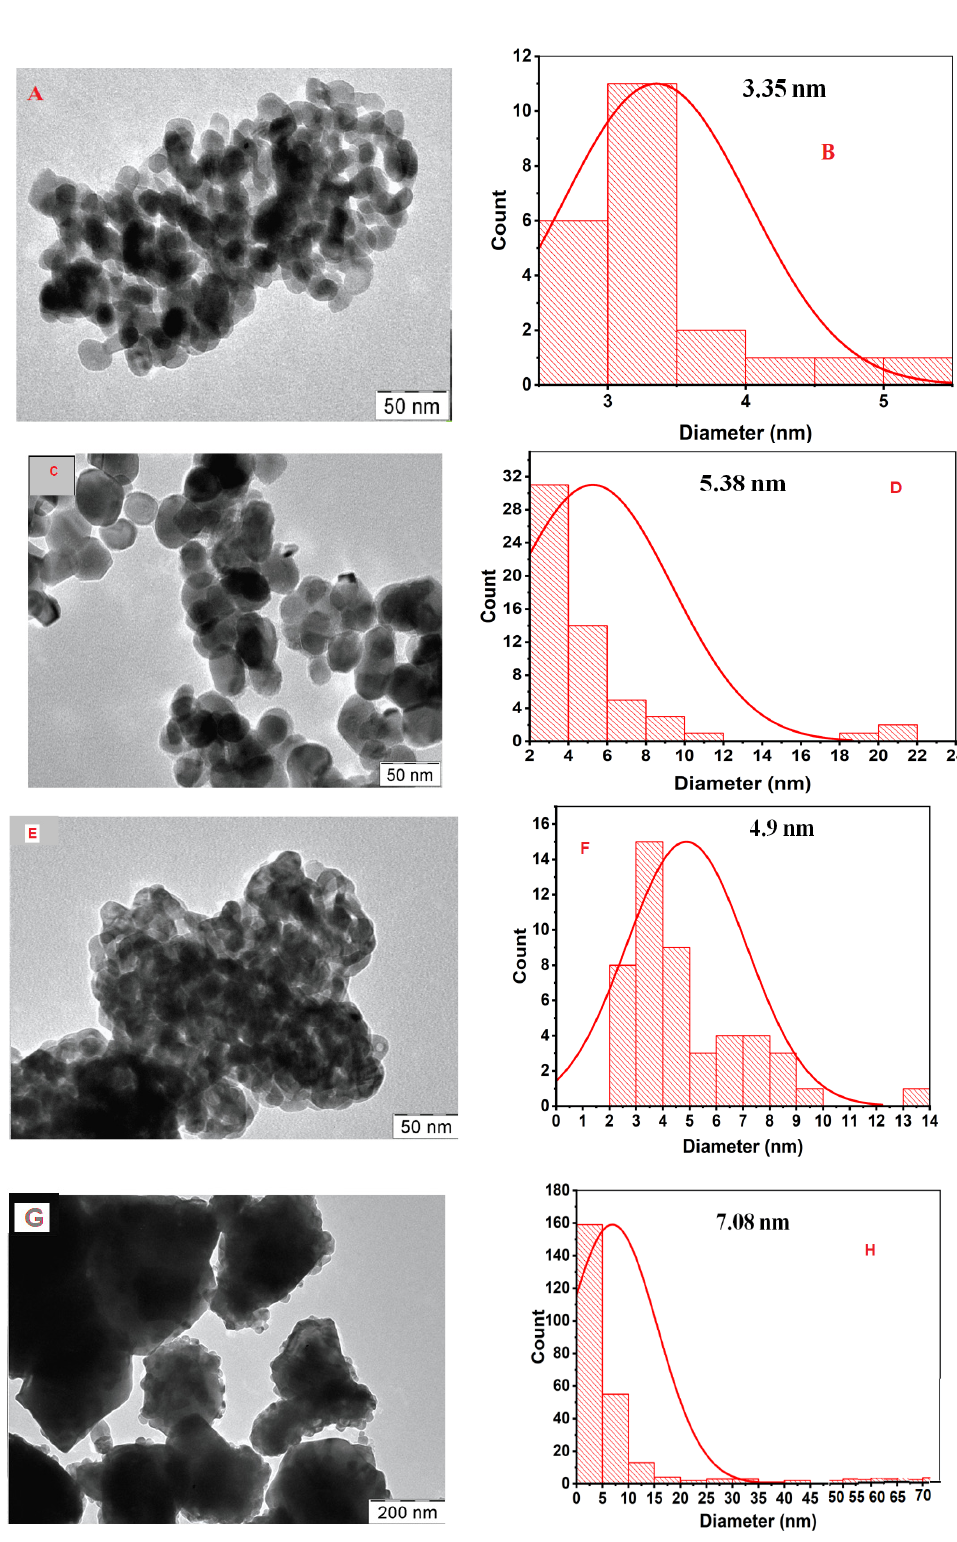
Figure 5. TEM images and matching particle size distribution for fresh: ( A , B ) 5Ni-RC100, ( C , D ) 5Ni-ELTN, ( E , F ) 5Ni-Z- 3215, and ( G , H ) 5Ni-MKnano catalysts calcined at 700 °C. ELTN, ( E , F ) 5Ni-Z-3215, and ( G , H ) 5Ni-MKnano catalysts calcined at 700 ◦